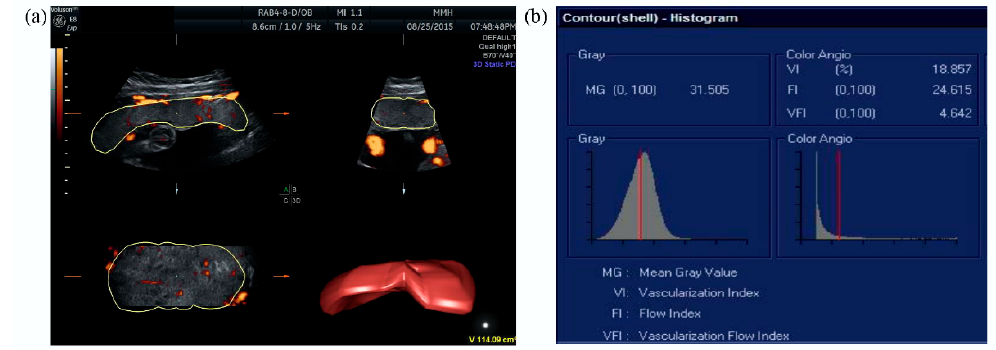
Figure 1. Placental vascular indices were assessed after evaluation of the whole placenta and calculated using Virtual Organ Computer-aided AnaLysis (VOCAL TM ) imaging software: ( a ) placental volume measurement and ( b ) determination of placental vascular indices using three-dimensional power Doppler.